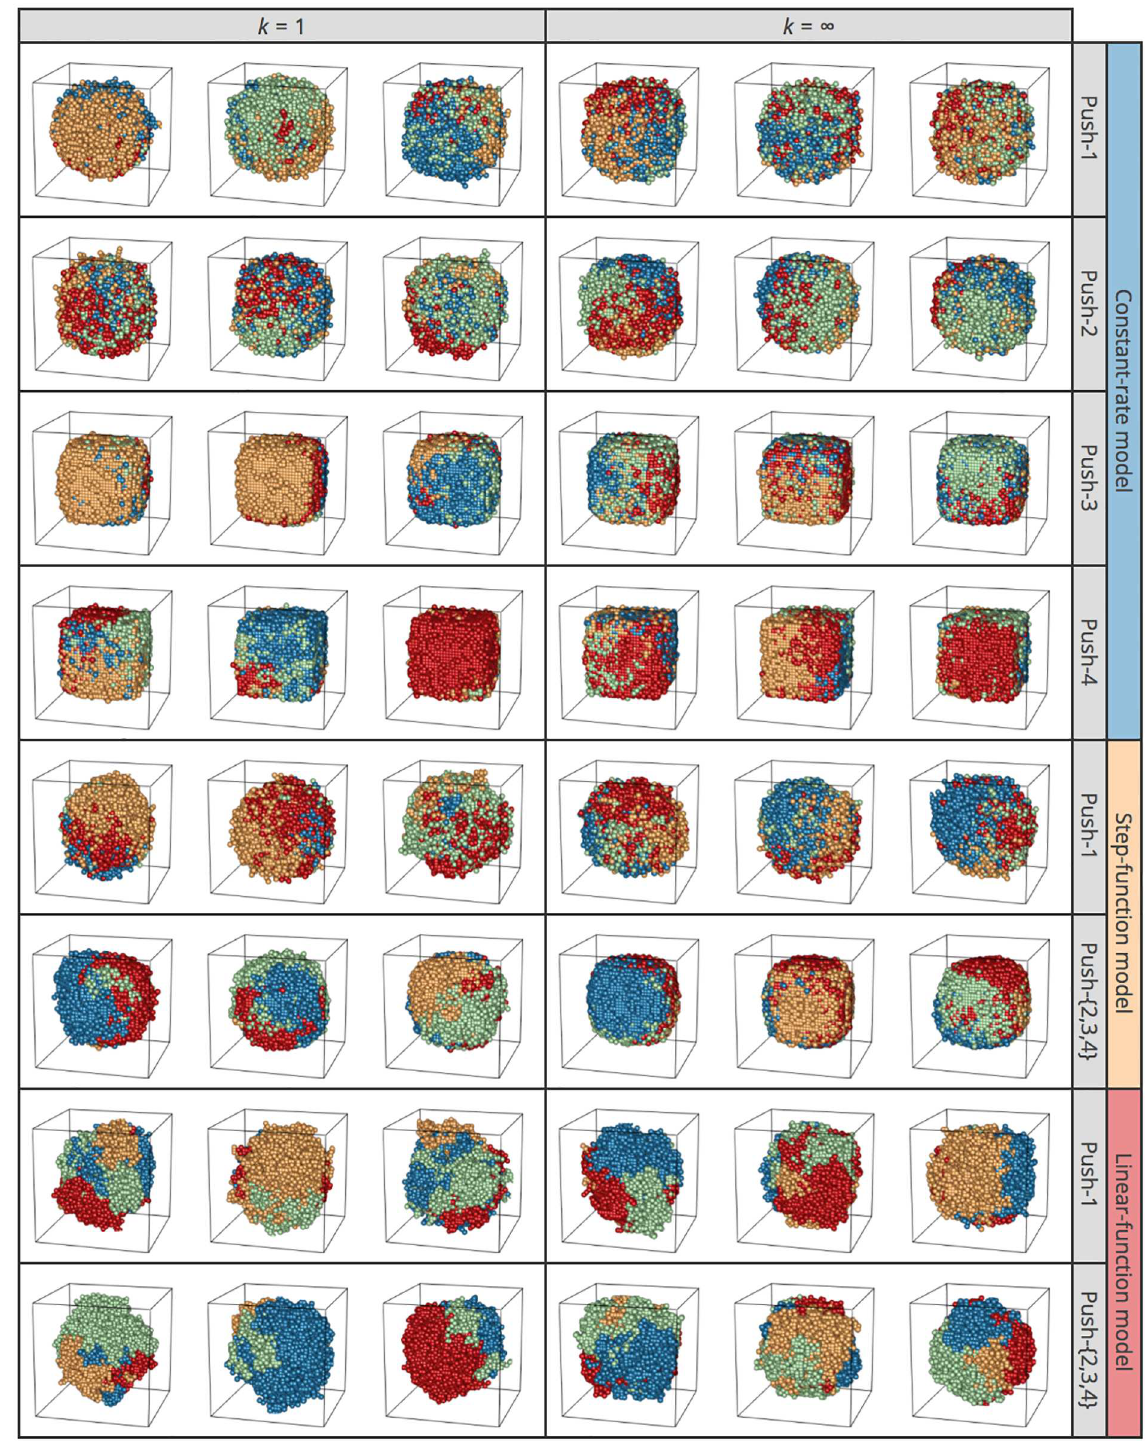
Fig 8. 3D structuresof simulated tumors for push methods 1–4 under constant-rate, step-function, and linear-function models under neutrality. Results for k = 1 and 1 are shown. Descendants from the first four cells in each simulationrun are shown in blue, green, yellow, and red. The results of three independentruns are shown for each setting.